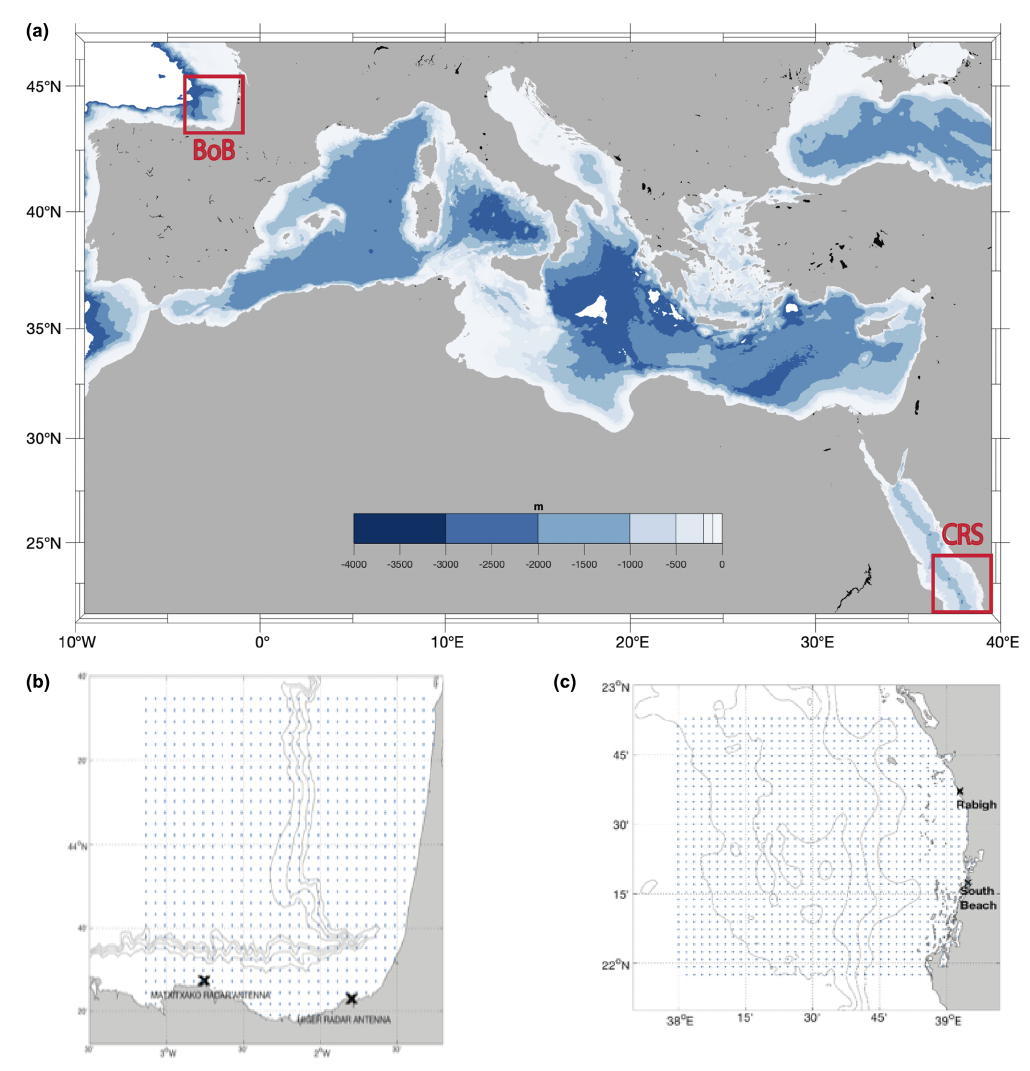
Figure 1. (a) A global view of both analyzed study areas. (b) HFR system of the BoB. (c) HFR system of the central Red Sea. Blue dots represent the data points, and the black crosses are the HFR antenna